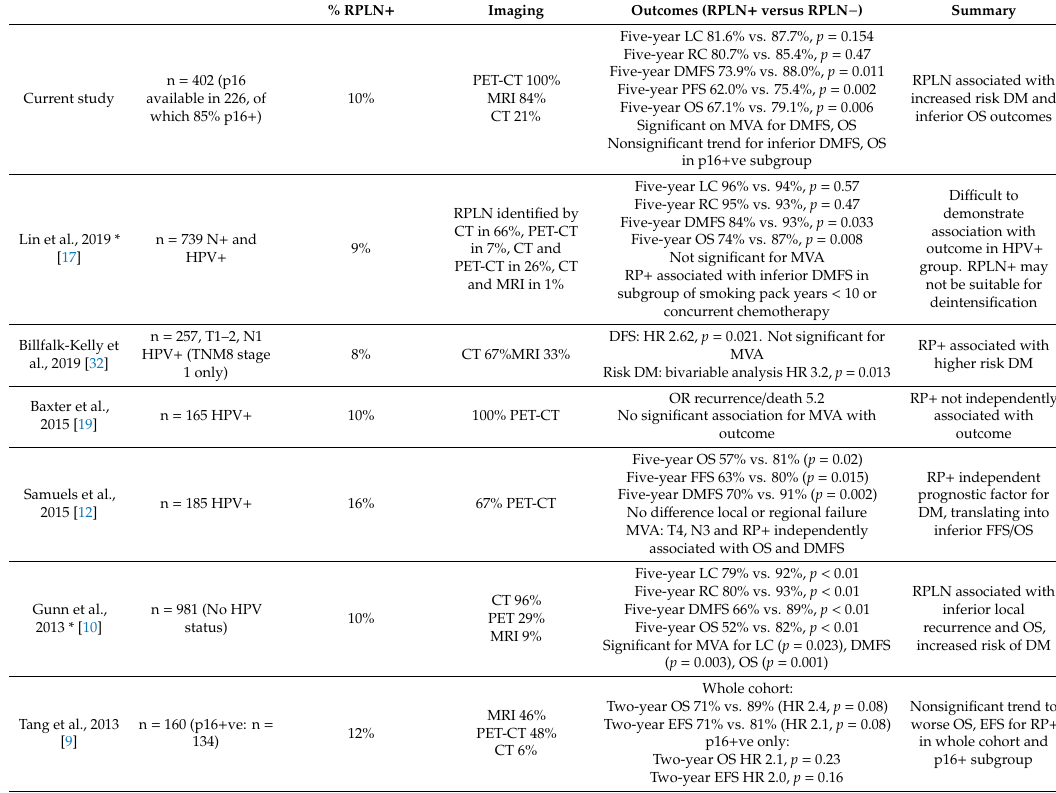
Table 4. Summary of literature reporting outcomes in relation to RPLN